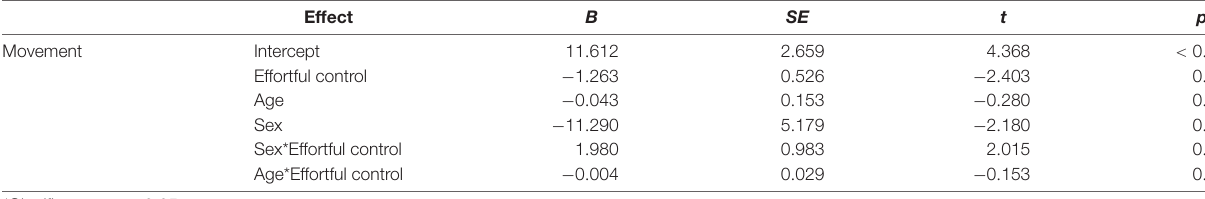
TABLE 5 | Regression results examining effects of Effortful Control, Age, Sex, and interactions. Effect